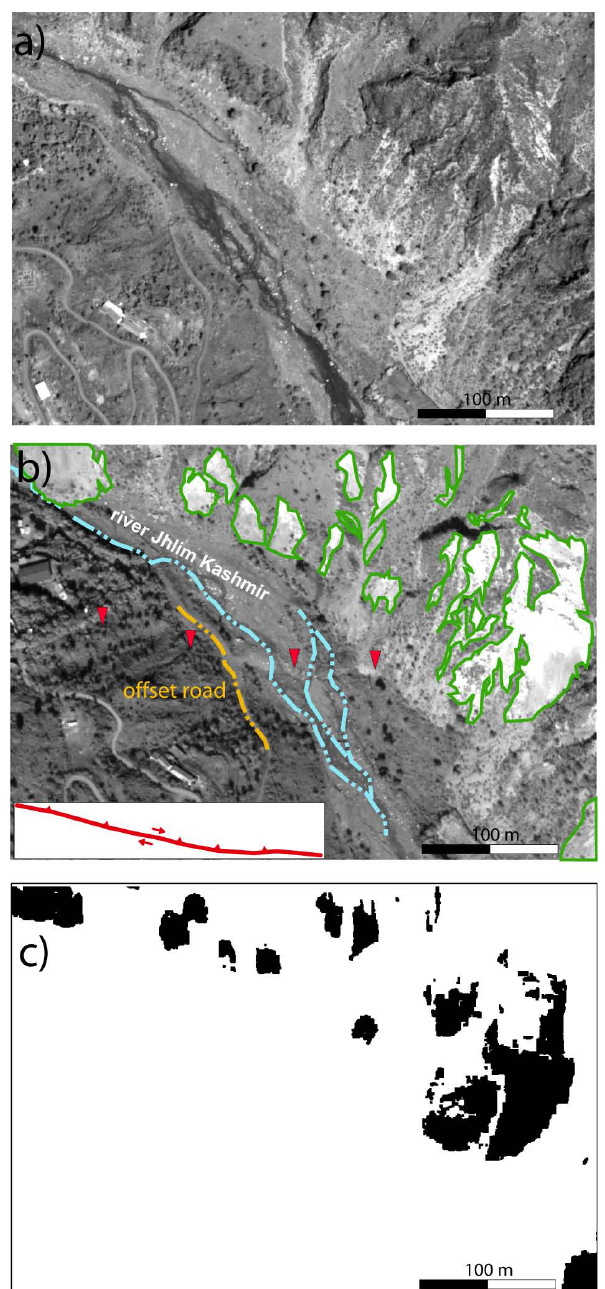
Fig. 6. (a) Pre-image (13 August 2004) of the area across the Jh- lim Kashmir river. (b) Post-event image (22 October 2005) of the same area. Surface rupture (red triangles) and landslides (contoured by green line) are mapped by visual inspection. Road and stream offsets across the rupture trace is also indicated (see text for discus- sion). On left corner is a sketch of the fault scarp (2 . 45 ± 0 . 25m (av. vertical separation). (c) Landslides (black areas) occurring in the area detected by the automatic classification.